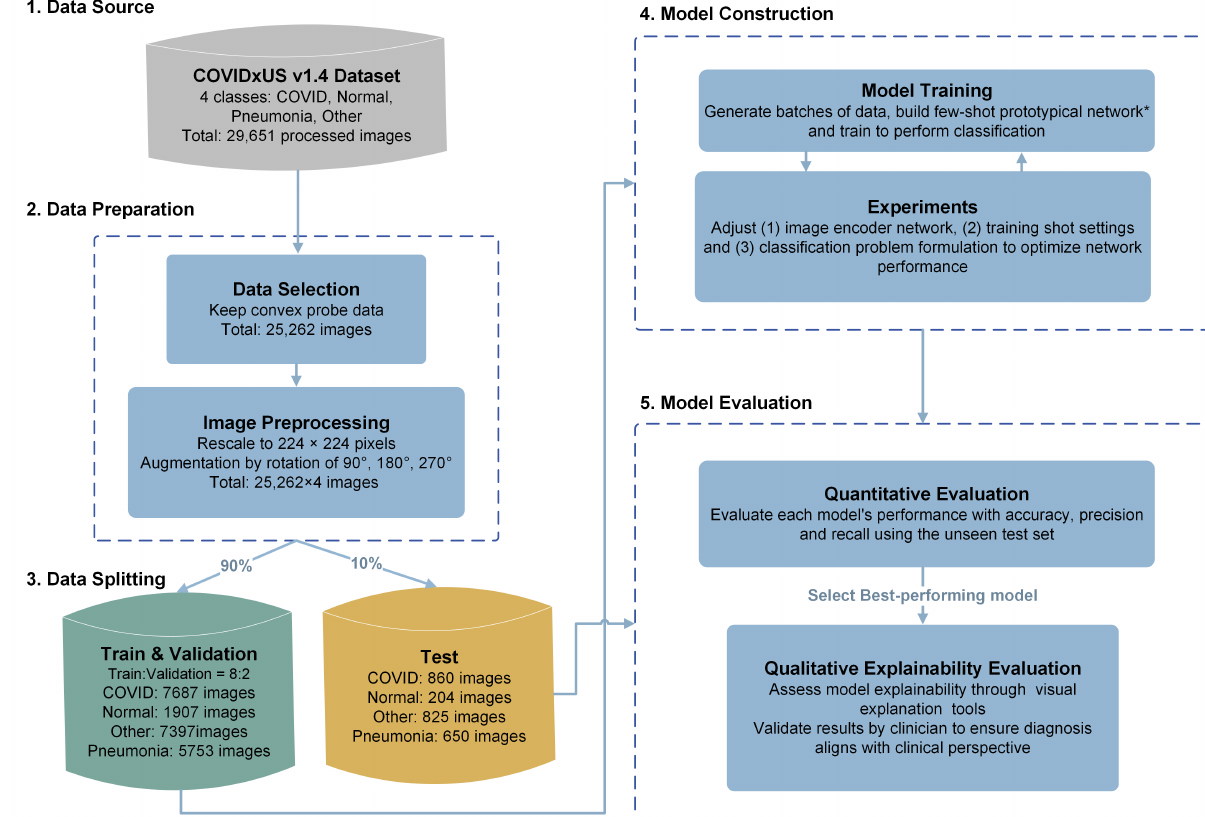
Figure 1. High-level conceptual flow of the